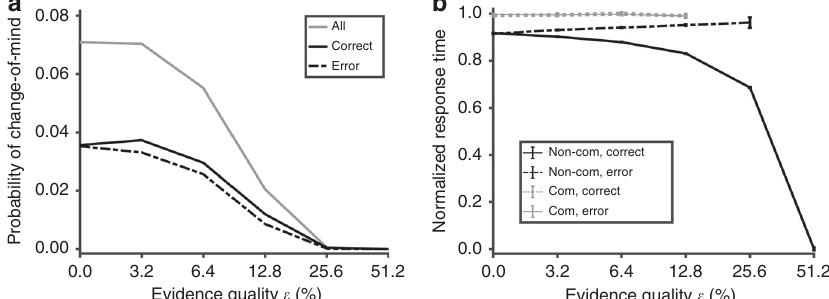
Fig. 4 Model accounts for and predicts key characteristics of change-of-mind. a Probability of change-of-mind with respect to evidence quality. Probability of change-of-mind for a single evidence quality level is calculated by dividing the total number of change-of-mind trials by the total number of simulated trials for a speci fi c evidence quality level (see “ Methods ” ). Grey: Total probability of change-of-mind, consisting of both correct and error choices. Solid black (dashed black): only subsequent correct (error) change-of-mind choices. Probability of change-of-mind for subsequent correct choices peak at ε = 3.2, before decreasing. b Response times are slower during change-of-mind (regardless of whether they are correct (dashed green) or error (bold brown)). Error bars are